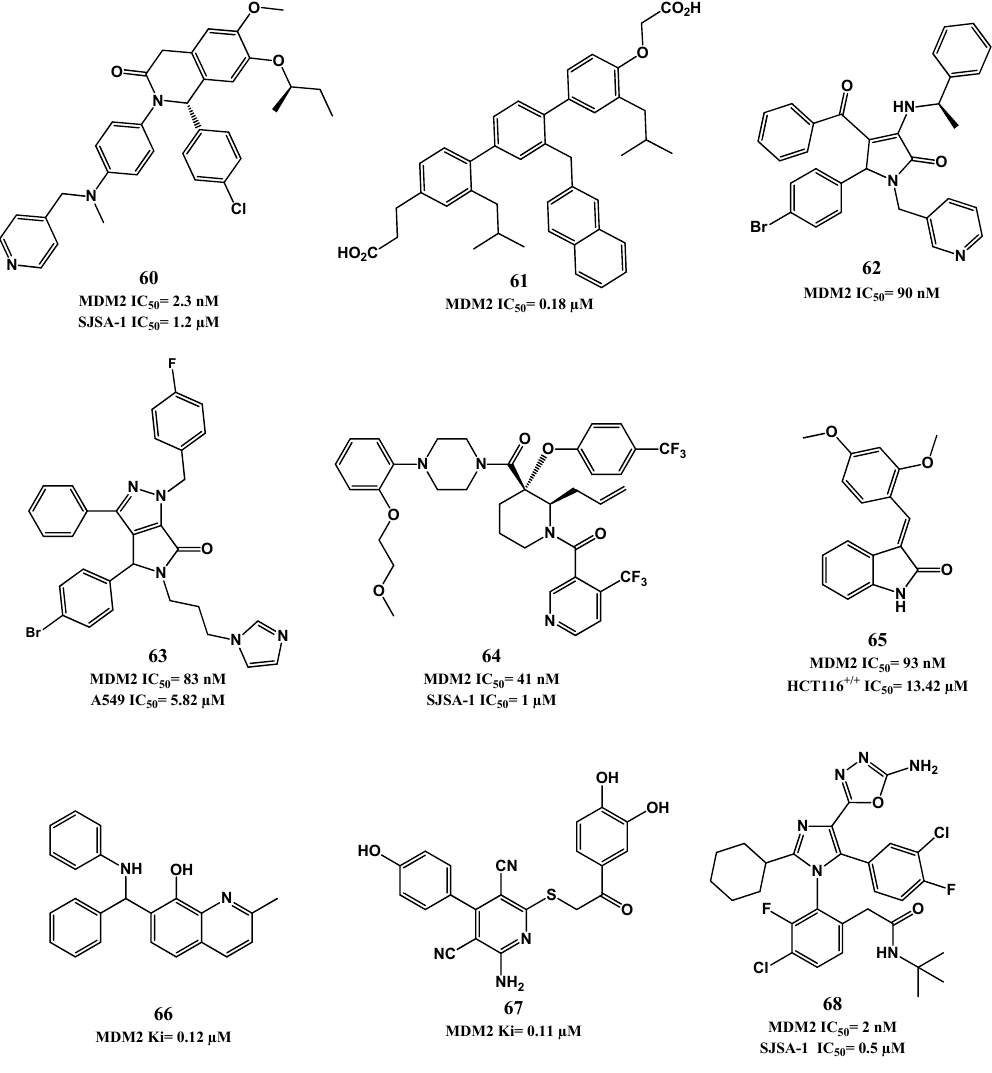
Figure 15. p53-MDM2 interaction inhibitors.